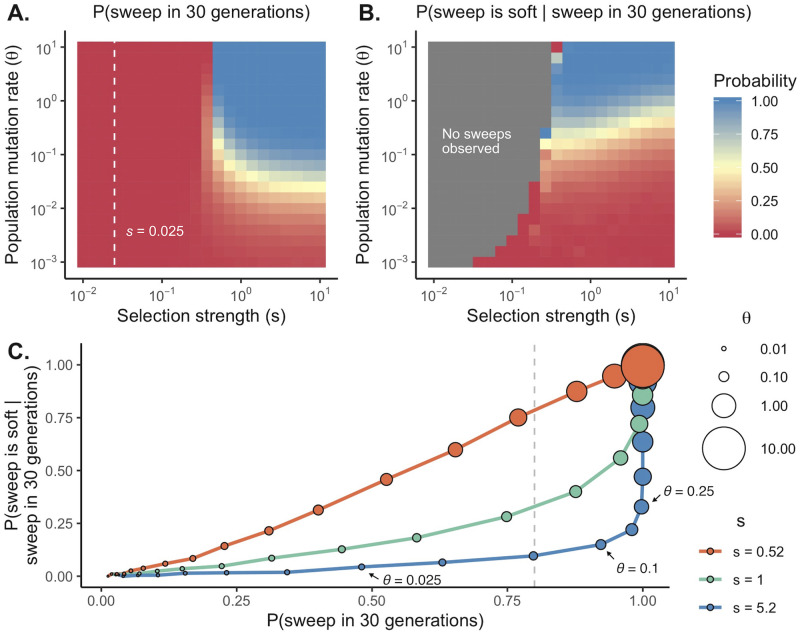
The probability of a sweep and a soft sweep are closely connected.For a variety of combinations of θ and s, we plot (A) the probability of the 1 or more beneficial alleles reaching 50% frequency in 30 generations, and (B) we plot the proportion of sweeps that are soft conditional on occurring. Gray squares indicate the beneficial allele(s) did not reach 50% frequency in any simulations, and the white dashed line indicates the selection strength of mutations conferring resistance to inefficient drugs simulated by Harris et al. (s = 0.025). In (C), we plot the relationship between how likely a sweep is and its probability of being soft conditional on occurring and find that the 2 are strongly, positively correlated P(sweep) = 80% (i.e., [13]) is shown in a dashed line. Point size shows increasing values of θ for fixed values of s (s = (0.52, 1, 5.2), shown in red, green, and blue). Other simulation parameters: 104 replicates, μ = 10−5.